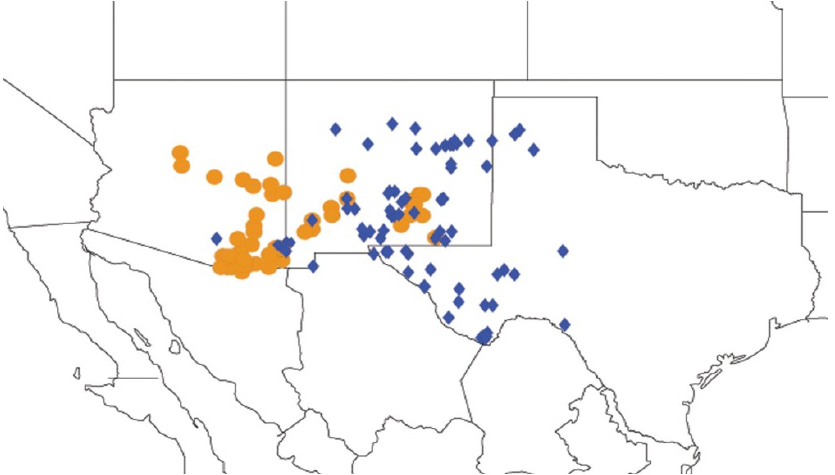
Figure 18. Distribution of Tibicen chiricahua (gold circles) and T. townsendii (blue